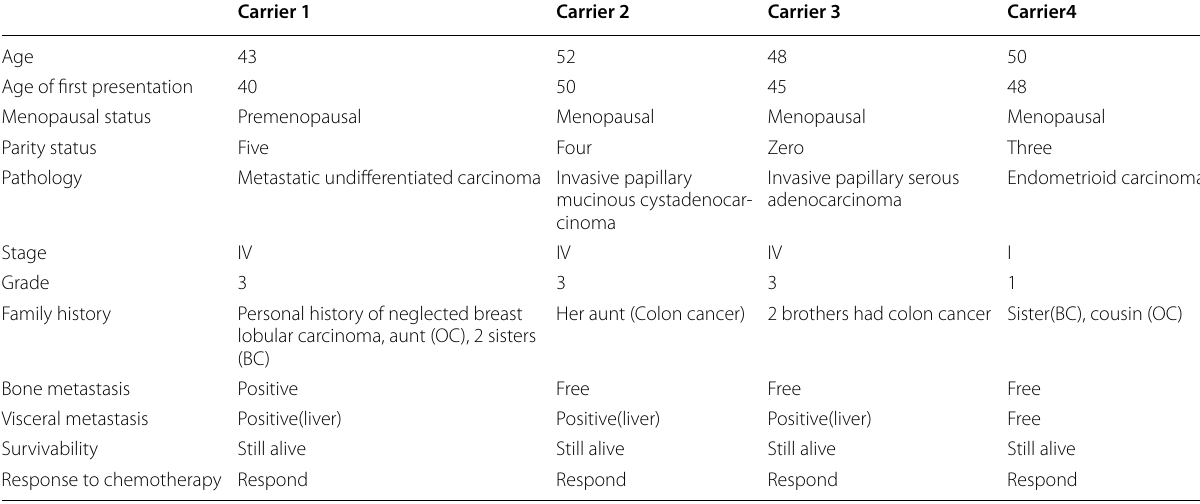
BC, breast cancer; OC, ovarian cancer; MAC, metastatic undifferentiated carcinoma; PSCC, papillary serous adenocarcinoma; PMCAC, papillary mucinous cystadenocarcinoma; EC, endometrioid carcinoma